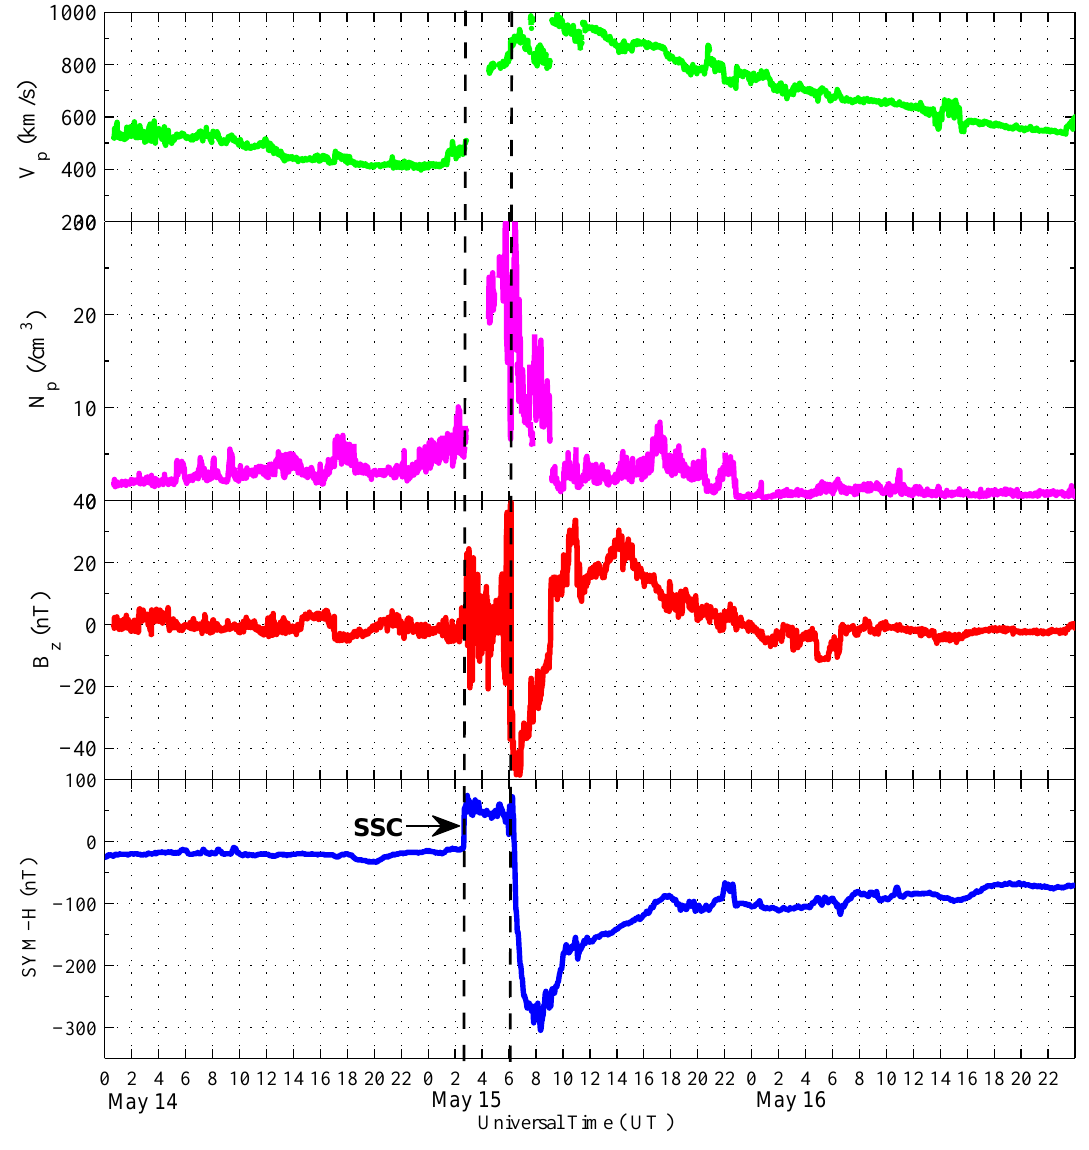
Fig. 1. The solar wind and geomagnetic parameters from 14–16 May 2005. Three panels from top are the solar wind (proton) speed (green), the proton density (magenta), the IMF- B z (red) as measured by ACE spacecarft and SYM-H index (blue) at